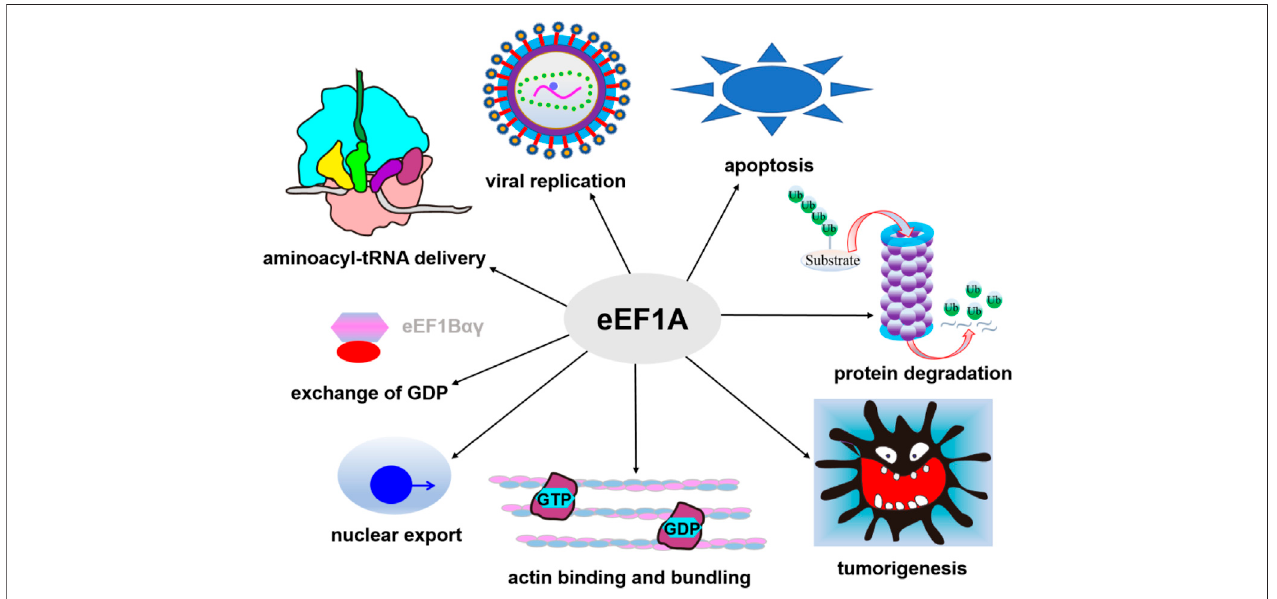
FIGURE 3 | Canonical and non-canonical functions of eEF1A. In addition to its canonical functions in transporting aa-tRNA, eEF1A is also involved in cytoskeleton organization,protein degradation, viralreplicationand propagation,nuclearprotein export, heatshockstressresponse, and signaling transductionpathway concerning apoptosis and